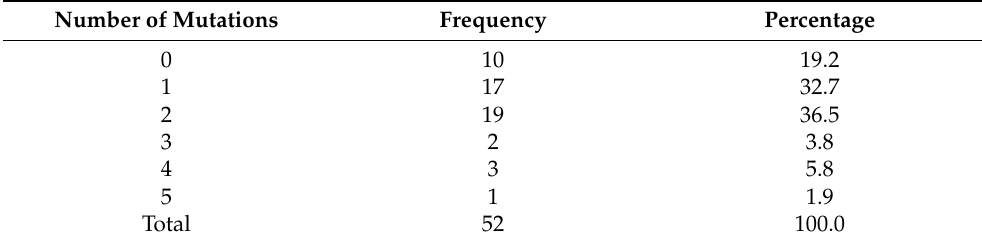
Figure 1. Radar chart showing the frequency of mutations in the lung biopsies of analyzed patients. TP53 (36.54%), KRAS (30.77%), EGFR (25%), PIK3CA (13.46%), and NOTCH1 (11.54%) were the most frequent mutations in the analyzed patients. Table 1. Frequency of single, double, triple, quadruple, and quintuple mutations in lung biopsies from the analyzed patients.